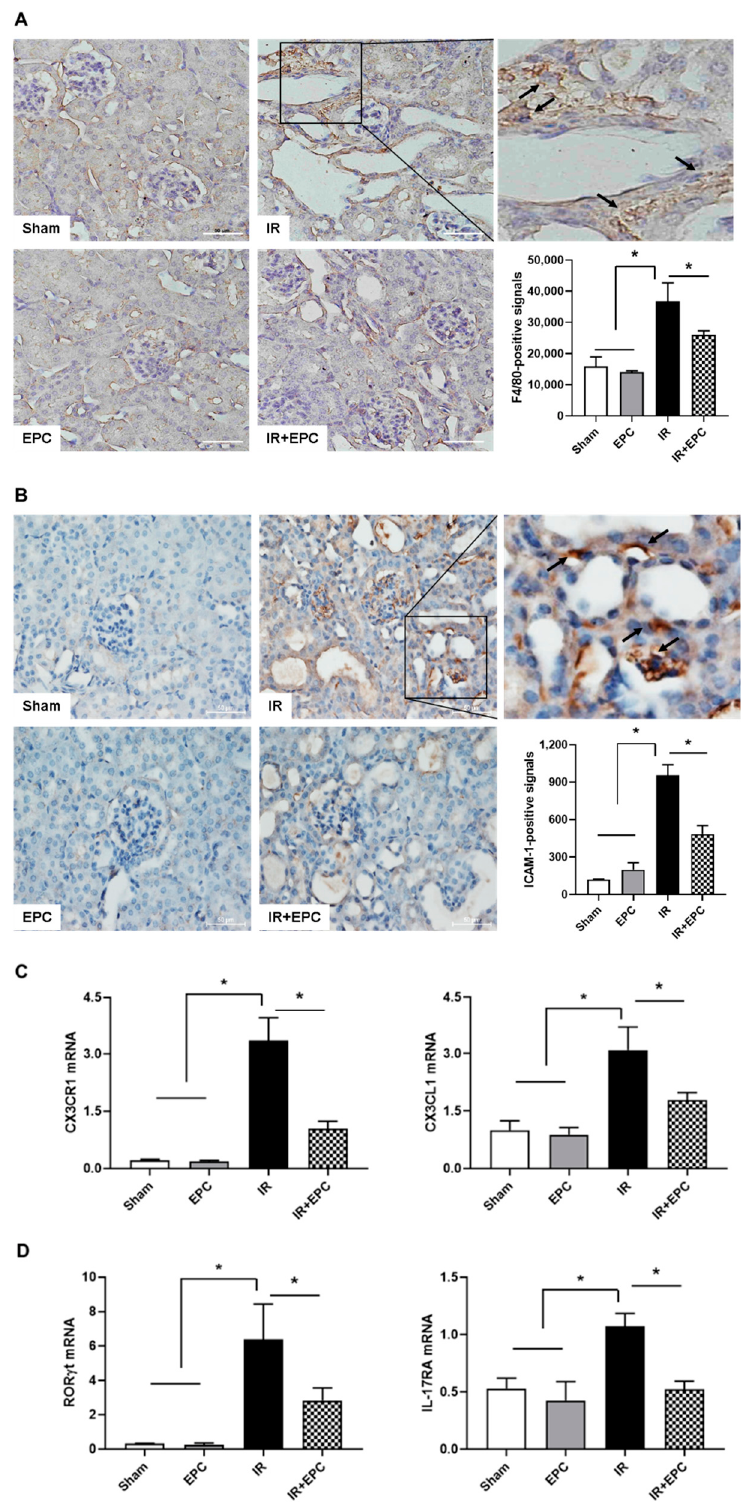
Figure 6. Effects of EPCs on IRI-induced inflammation by immune modulation. F4/80 immunohisto- chemical staining was performed to verify macrophage infiltration ( A ). F4/80-positive signals were found in the interstitial areas of the kidneys after IRI. Immunohistochemical staining of the inflam- matory mediator ICAM-1 was examined ( B ). All signals were analyzed by densitometry. mRNA expression levels of CX3CL1, CX3CR1, ROR γ t, and IL-17RA were analyzed by quantitative real-time PCR ( C , D ). Scale bar, 50 μ m. Data are means ± SEMs. * p < 0.05.